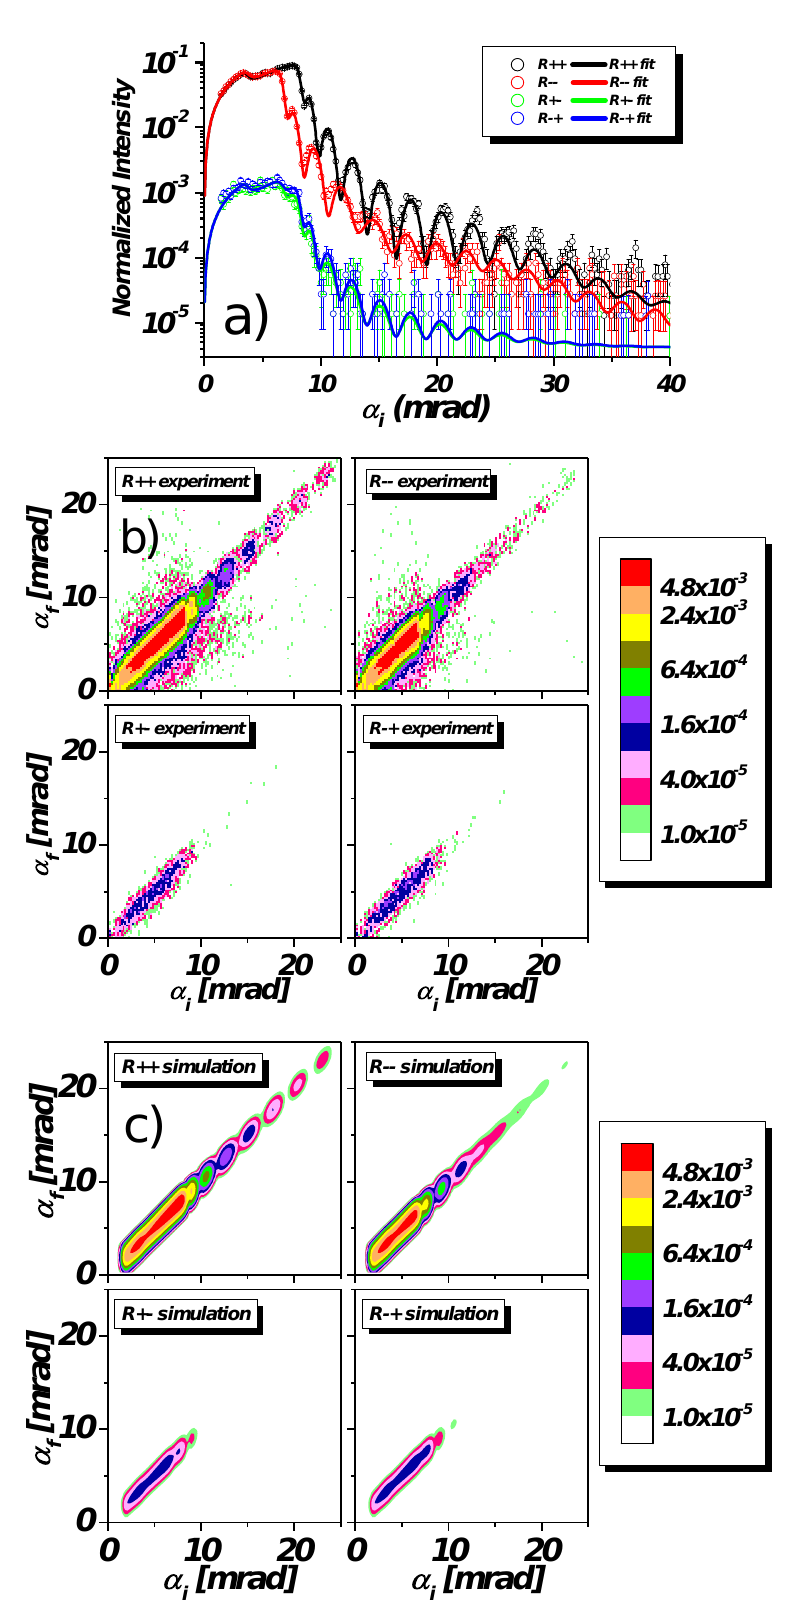
Figure 8. ( a ) NSF and SF reflectivities for the stripes oriented parallel to the scattering plane in a field of H ext = 5.2 kOe applied across the stripes. ( b ) Off-specular scattering maps and ( c ) corresponding model